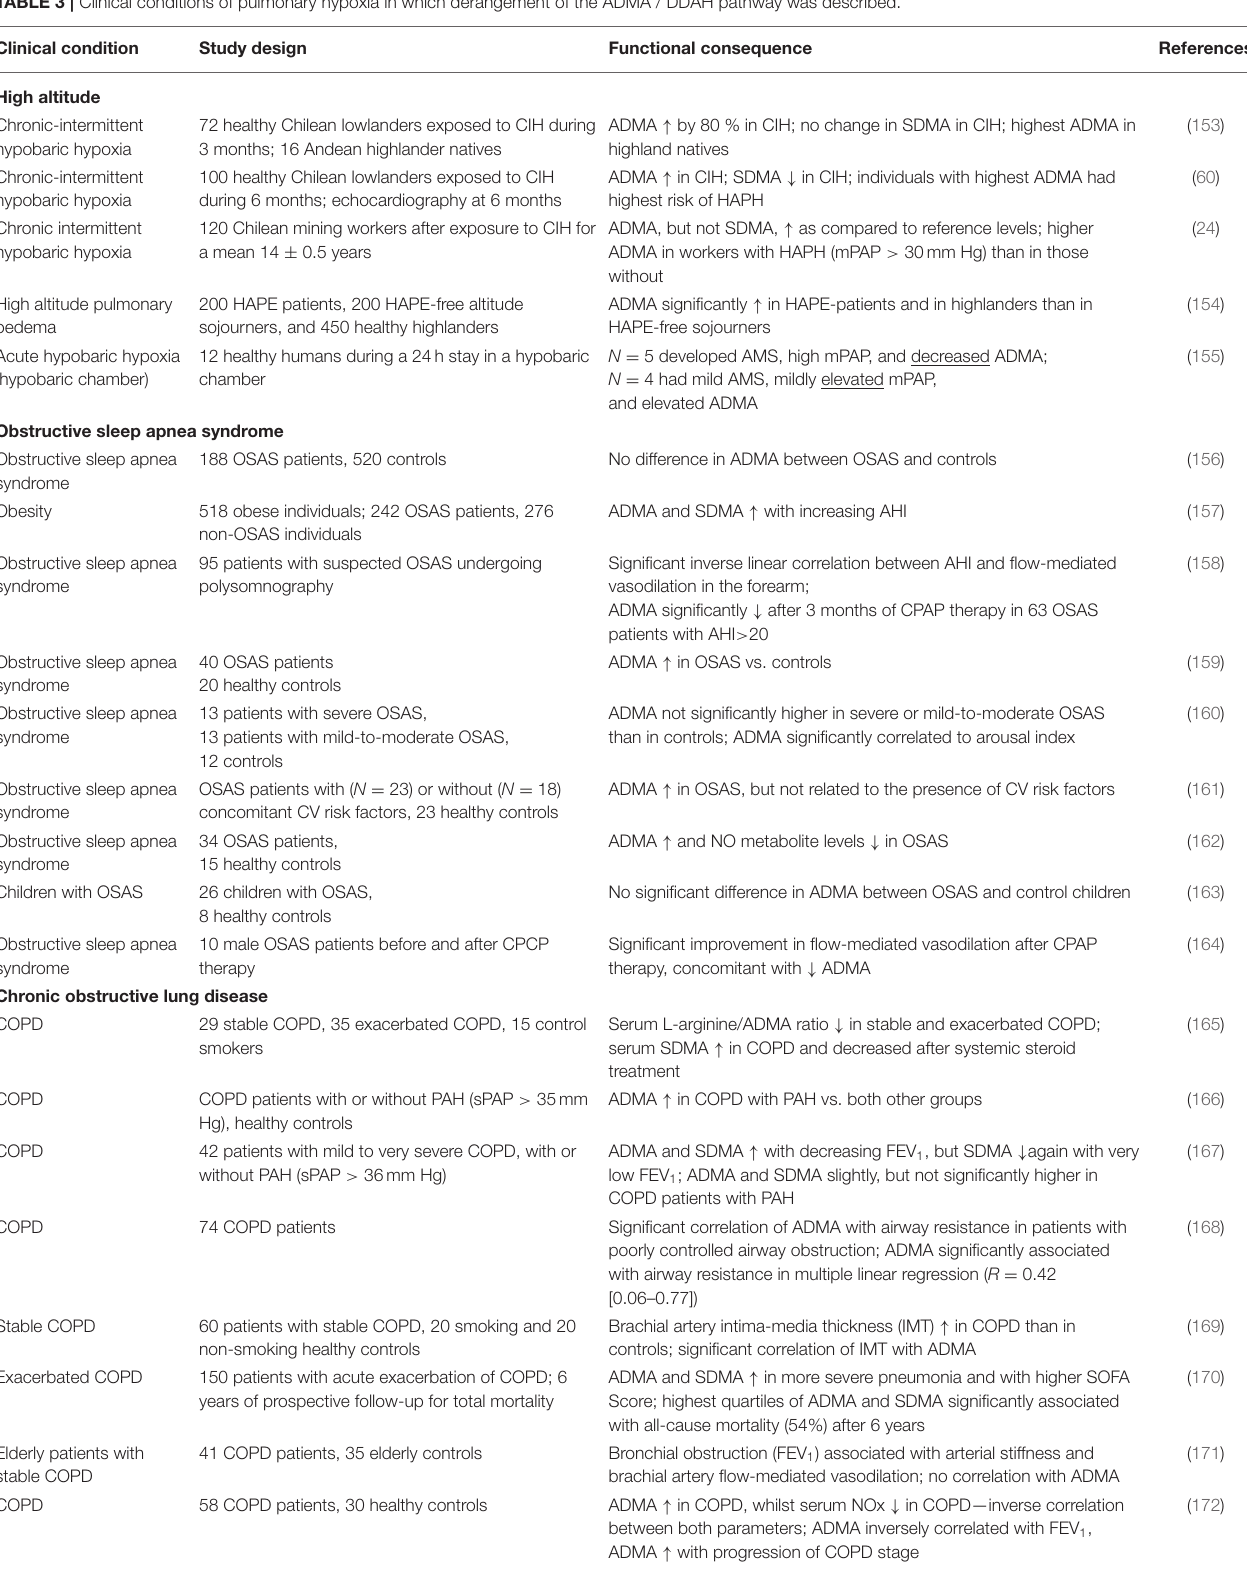
TABLE 3 | Clinical conditions of pulmonary hypoxia in which derangement of the ADMA / DDAH pathway was